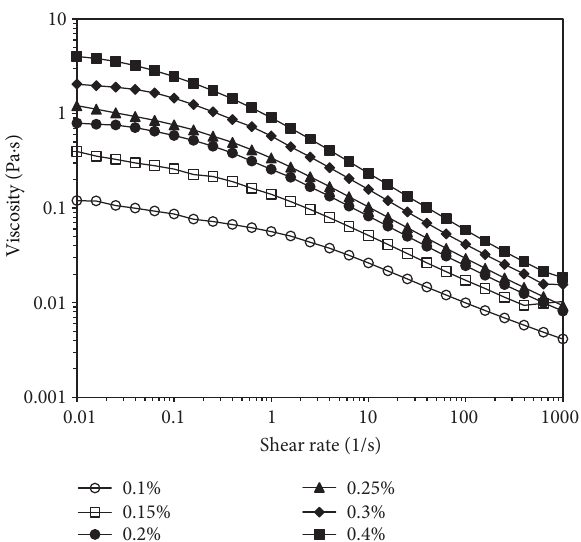
Figure 11: Steady state viscosity profile of SP solutions with varying concentration of copolymer at 50 ∘ C.